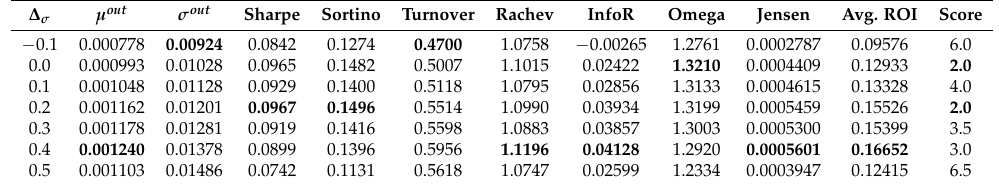
Table 19. CIB: out-of-sample performance results for the KP R strategy by varying ∆ σ (with ∆ γ = 0.8).